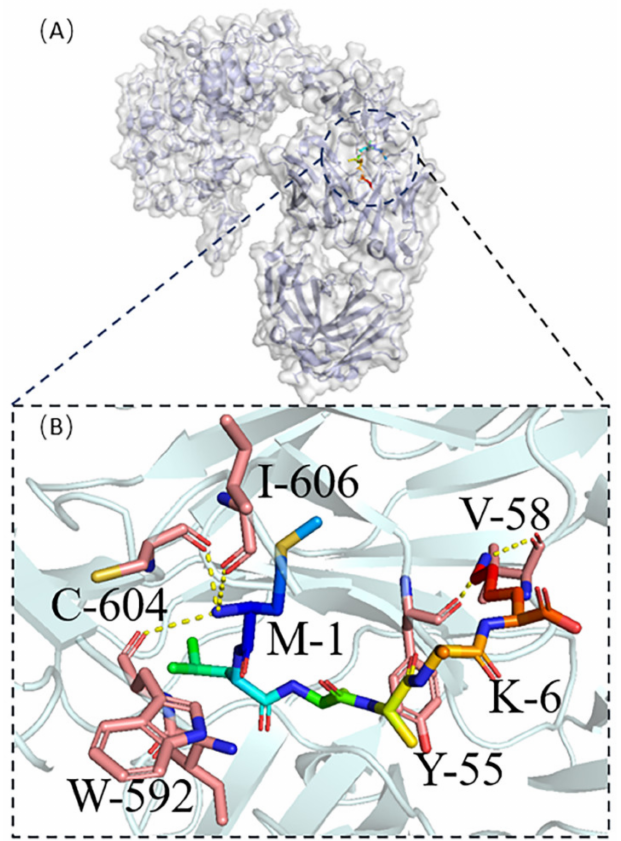
Figure 5. ( A ) Protein No. 1- HER2 complexes, ( B ) The active residues around Protein No. 1 binding to HER2 complexed with the Herceptin antigen-binding